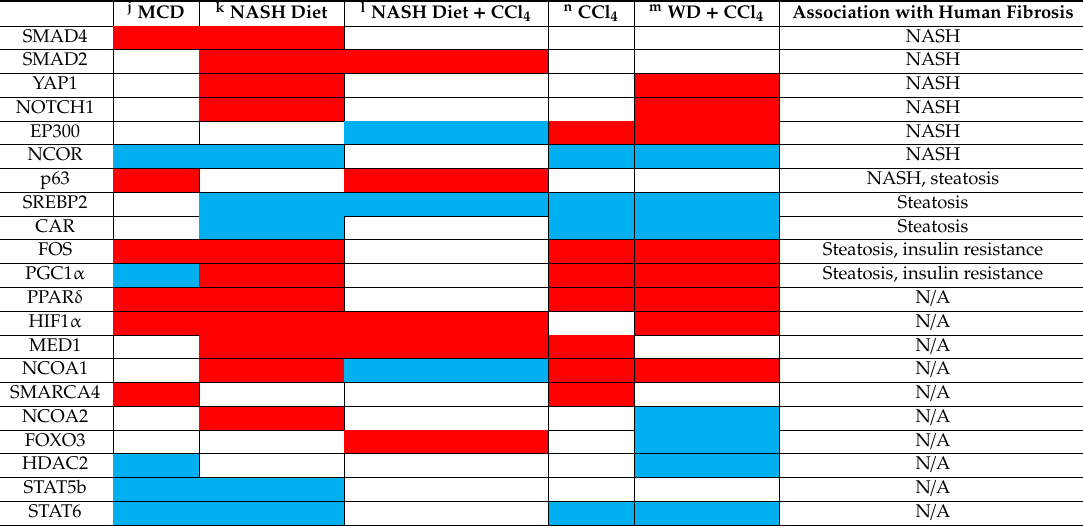
Mouse models of NASH using j MCD diet (GSE93132), k NASH diet (GSE52748), l NASH diet coupled with CCl